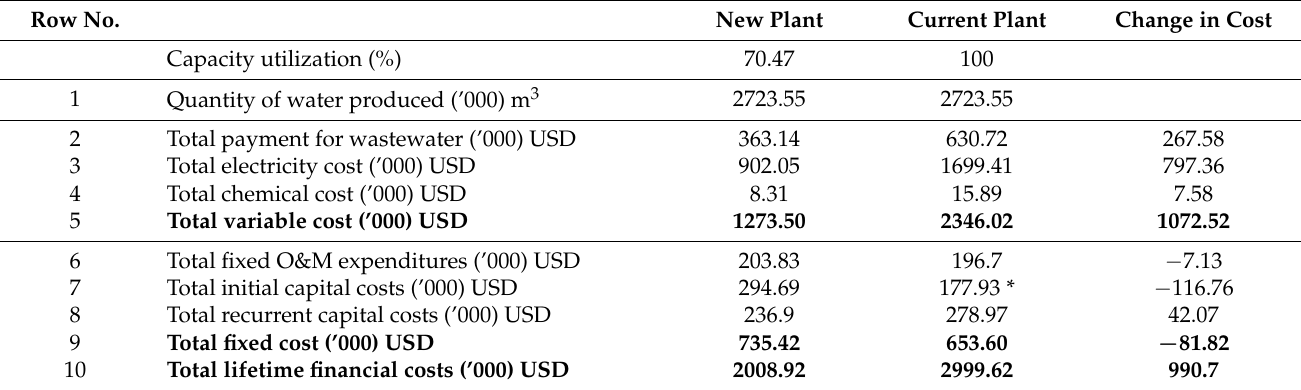
Table 5. Present value of financial output and costs in terms of equal production in the two plants, in 2022 prices.